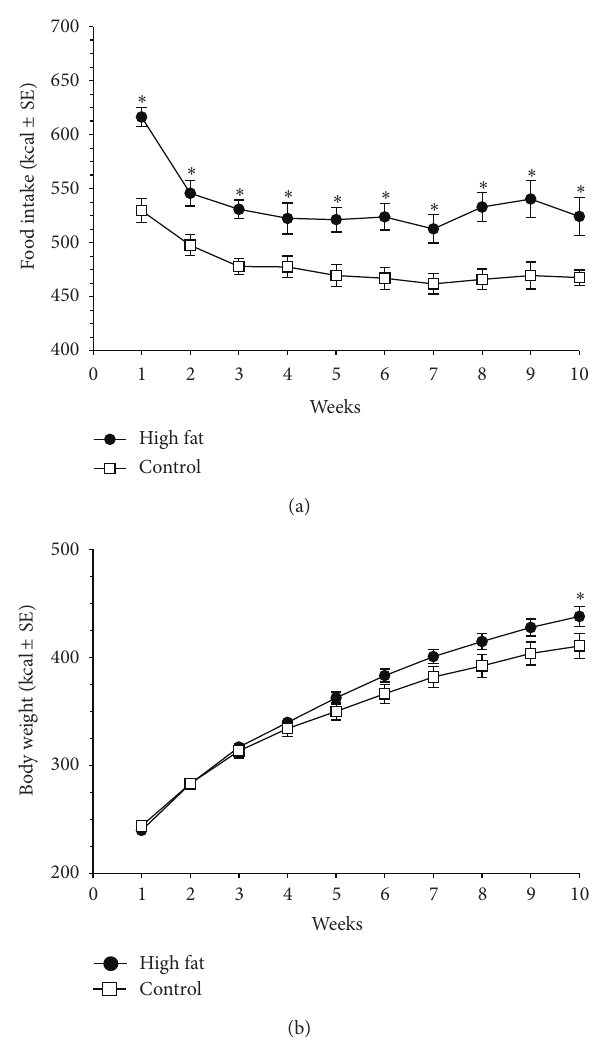
F 3: Effects of high-fat and control diets over 10 weeks. Values